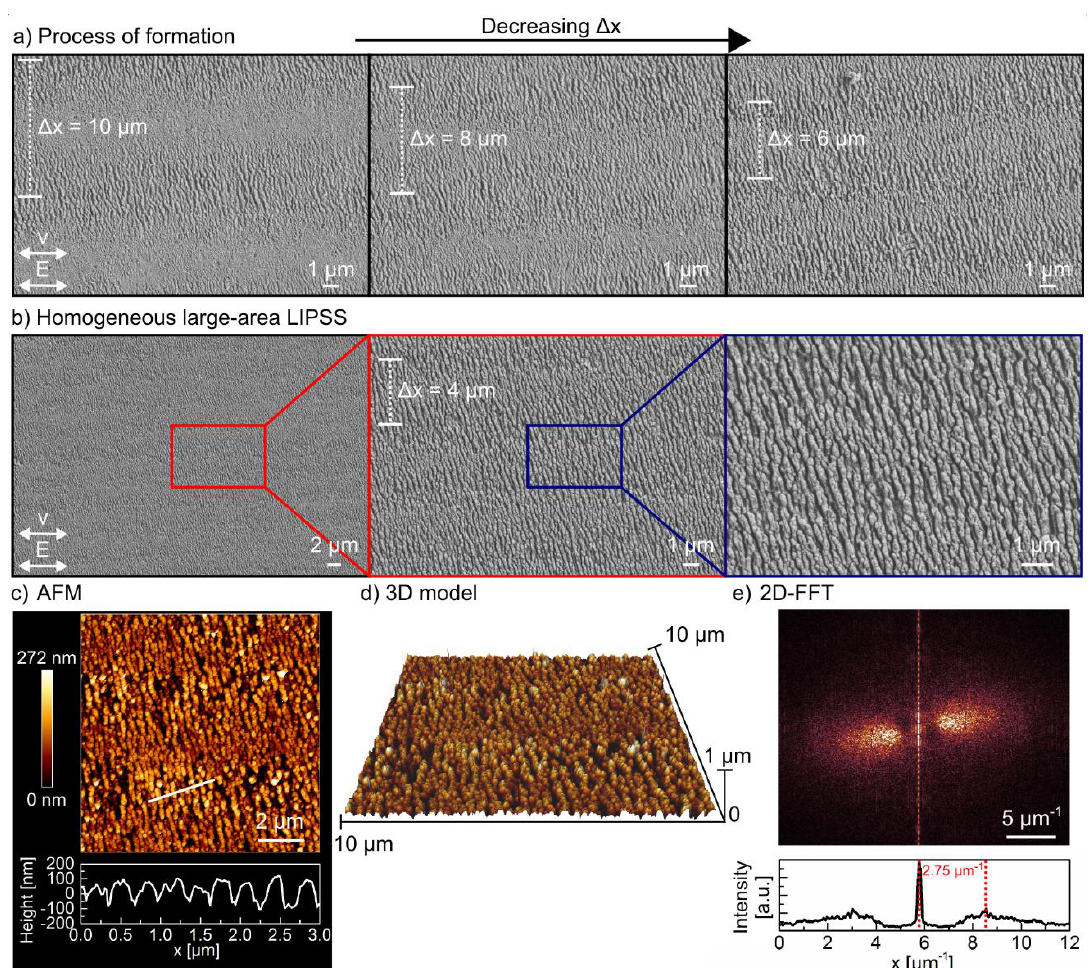
Figure 5. Large-area structuring of fused silica substrates homogeneously with HSFL using a 20 nm thin gold layer: ( a ) SEM micrographs of line scans performed with v = 0.15 m/s, F = 4.5 J/cm 2 , and different line spacing ∆ x ranging from 10 to 6 µm; ( b ) SEM micrographs of different magnification showing a homogenous HSFL pattern fabricated with v = 0.15 m/s ( N = 63), F = 4.5 J/cm 2 , and ∆ x = 4 µm; ( c , d ) atomic force microscopy (AFM) image, cross section; and 3D model of the HSFL shown in ( b ); ( e ) 2-D Fourier transform of the SEM micrograph shown in ( b ); Please note the direction of the E -field vector displayed in ( a , b ).